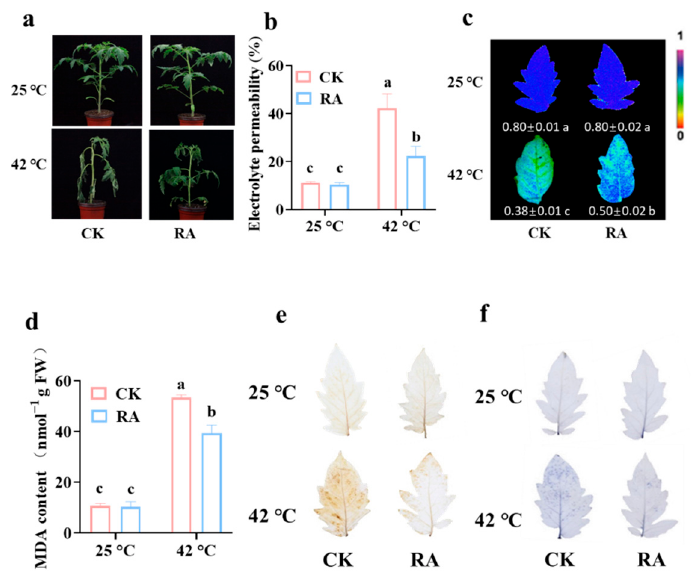
Figure 1. Effect of RA in tomato thermotolerance. ( a ) Representative images of tomato plants as influenced by RA and high-temperature treatment. Five-week-old tomato plants were pretreated with 2 mmol L − 1 RA or dH 2 O control once per day for three successive days. Then, the plants were subjected to normal temperature (25 °C) or high temperature (42 °C) for 12 h. ( b ) The electrolyte leakage of tomato leaves after 12 h of different temperature treatments. ( c ) The representative leaf images show the Fv/Fm value after 12 h of different temperature treatments. The color gradient scale on the right indicates the magnitude of the fluorescence signal represented by each color. ( d ) the MDA content in tomato leaves after 12 h of different temperature treatments. ( e ) Representative images of H 2 O 2 accumulation as determined by DAB staining. ( f ) Representative images of O 2 • − accumulation as determined by NBT staining. The data presented in ( b – d ) are the mean values ± SD, n = 3. Statistically significant differences between treatments ( p < 0.05, Tukey’s test) are shown by different letters.